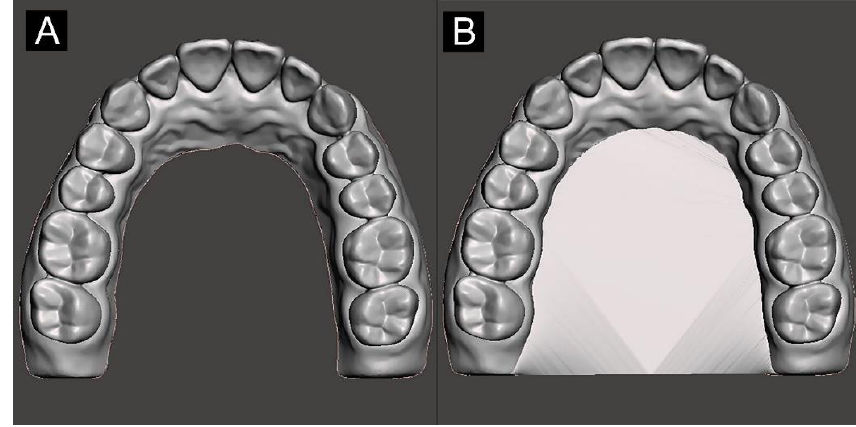
Figure 1. Flowchart of the overall experimental process of this study.